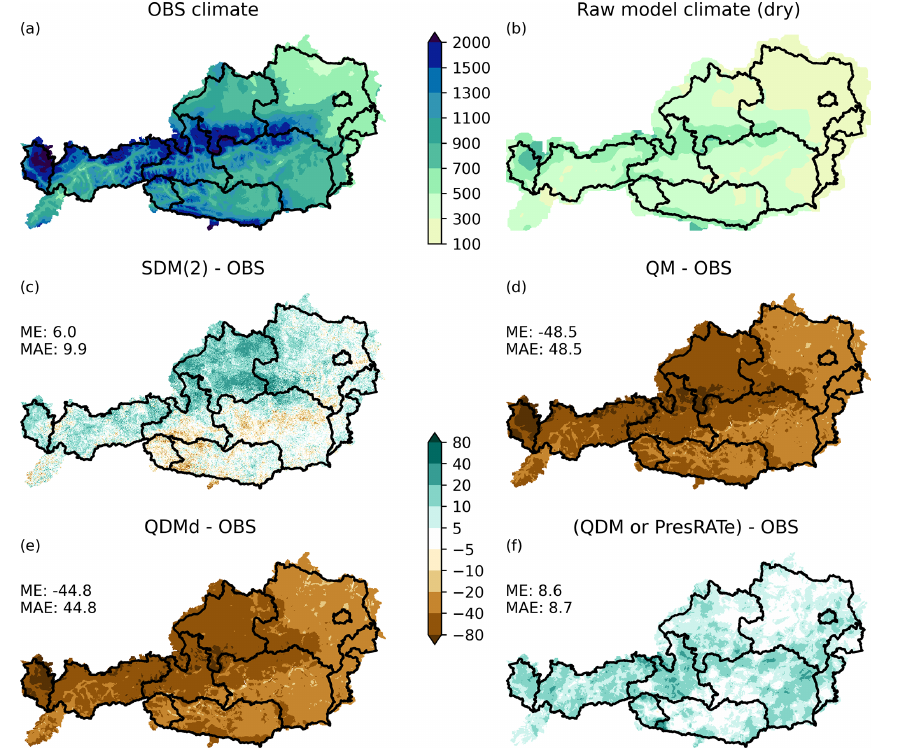
Figure 7. Climatological annual precipitation (mm) sum in the historical period for dry model data. (a) OBS annual precipitation. (b) Raw model (dry) annual precipitation. (c–f) Difference in annual precipitation (model minus observed data) in millimeters for (c) SDM, (d) QM, (e) QDMd (QDM without wet day algorithm) and (f)